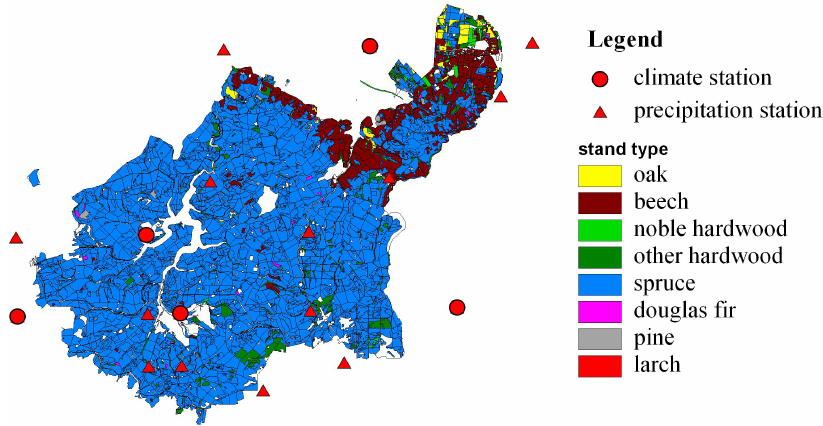
Fig. 1. Overview of the Oker catchment (Northern Harz Mountains) with stand type and climate stations (white areas: non-forest land